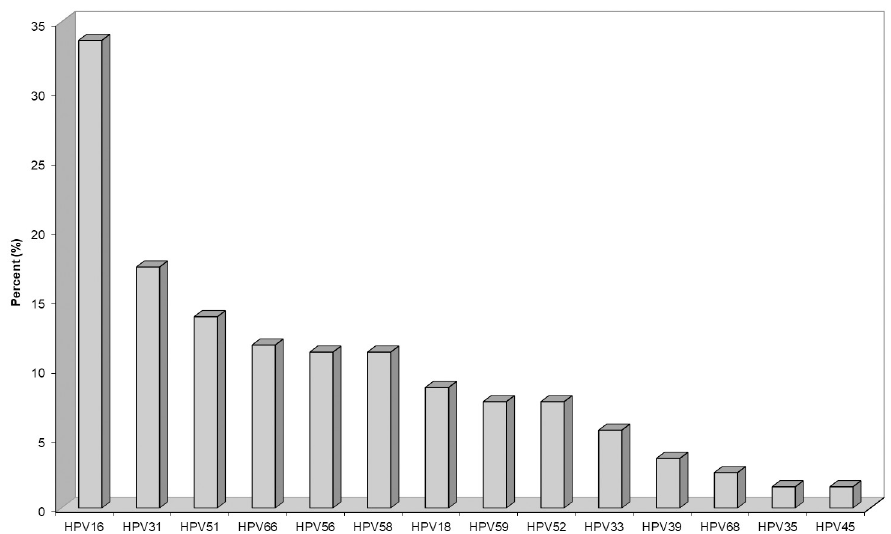
Fig 5. HR-HPV genotypes distribution in the study population. The bars represent a single or multiple type infection, whilst in multiple types the case is classified according to the highest risk type for its